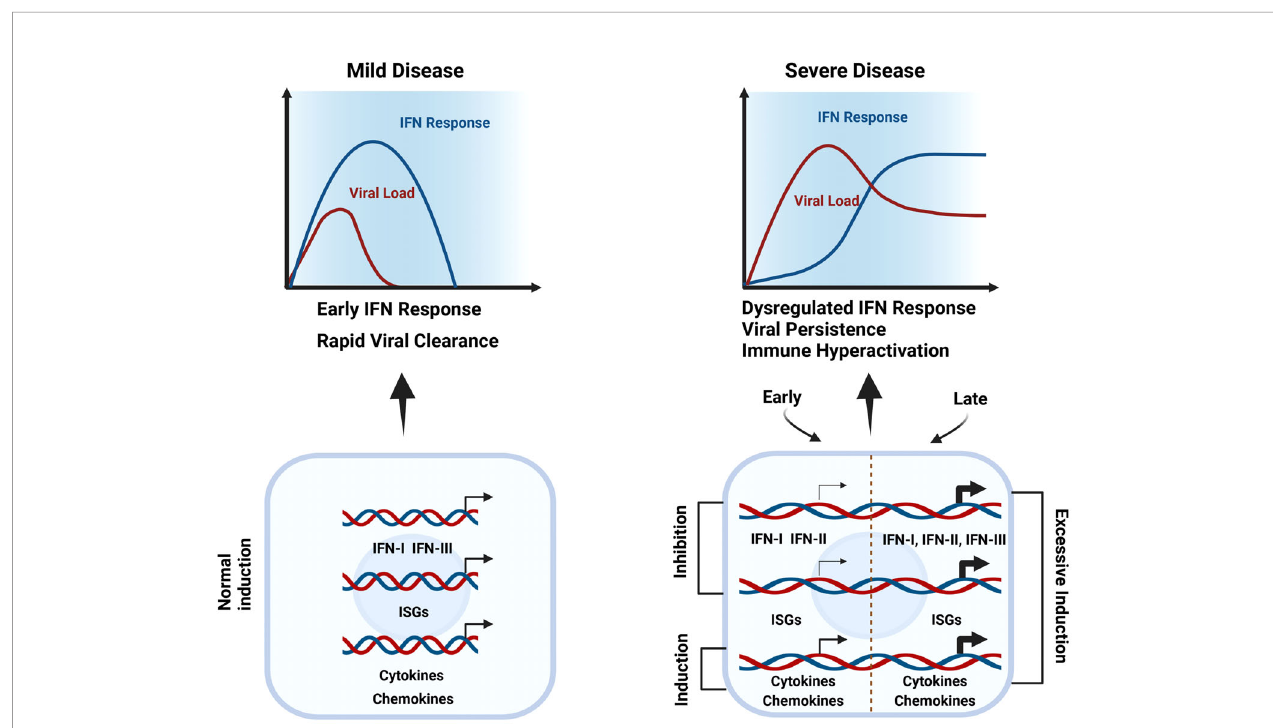
FIGURE 1 | Dysregulated IFN responses & immune hyper-activation in severe COVID-19. During mild disease, the initial viral burden is low and IFNs, together with cytokines, chemokines, and other ISGs are induced early and rapidly to mediate effective viral clearance (left). In severe COVID-19 (right), in the upper respiratory tract interferon production and ISG expression are inhibited by SARS-CoV-2, diminishing the immune response and promoting virus survival (Early). But by the time the virus enters the lower respiratory tract, an exuberant immune response is activated, including excessive upregulation of interferons, cytokines, chemokines, and other ISGs that at this point are harmful (Late). Thus, both early-stage de fi ciencies in type I IFN responses and late-stage IFN hyper-responsiveness are clear characteristics of severe